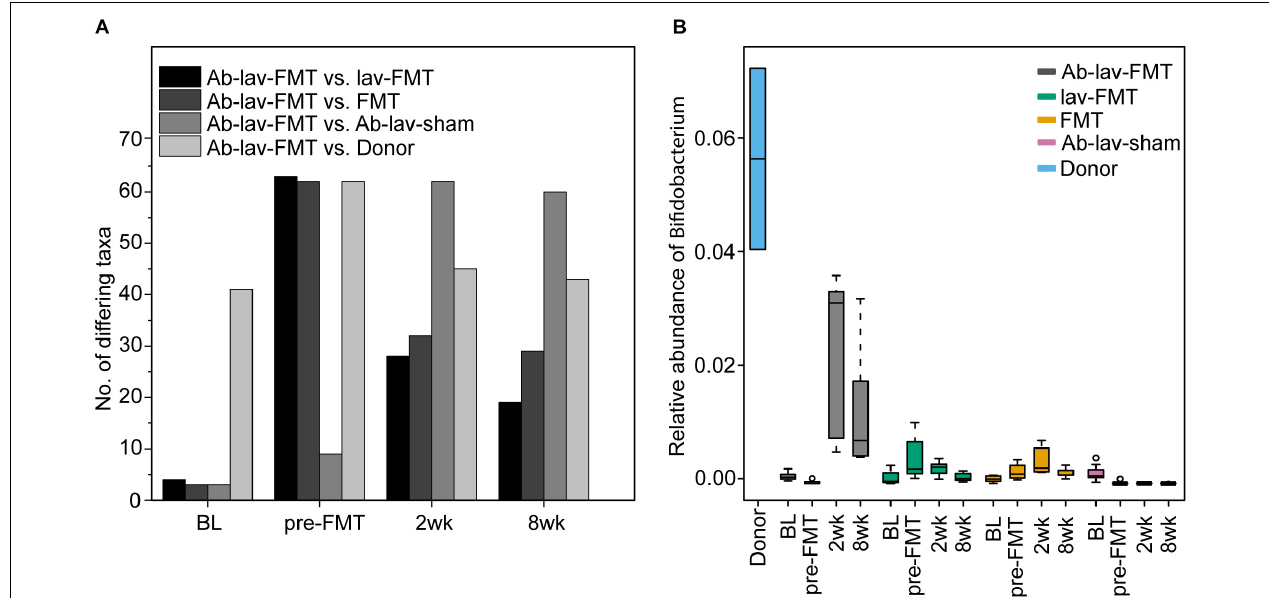
FIGURE 5 | (A) Number of genus-level bacterial taxa that differed in relative abundance (FDR-adjusted p < 0.05) between the Ab-lav-FMT group versus all other groups, or versus donor, at four different time points. (B) Relative abundance of genus Bifidobacterium, demonstrating higher levels in Balb/c donor than in C57BL/6 recipient mice. Relative abundance increased in the Ab-lav-FMT group at 2 and 8 weeks after FMT compared with baseline ( p = 5.59 × 10 − 9 and 6.02 × 10 − 6 , respectively), and also compared with other groups at 2 weeks after FMT (FDR-adjusted p < 0.05). On the other hand, levels of Bifidobacterium were decreased in the Ab-lav-sham group after antibiotic treatment and remained low until 8 weeks after sham